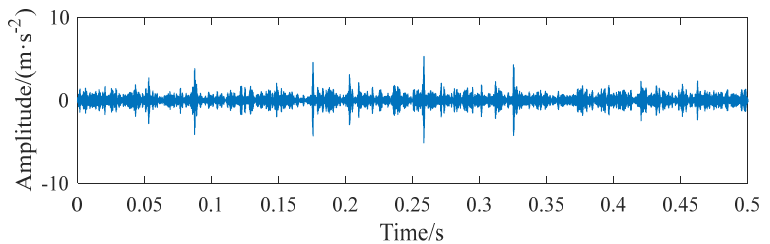
Figure 18. The waveform of the 10th component.